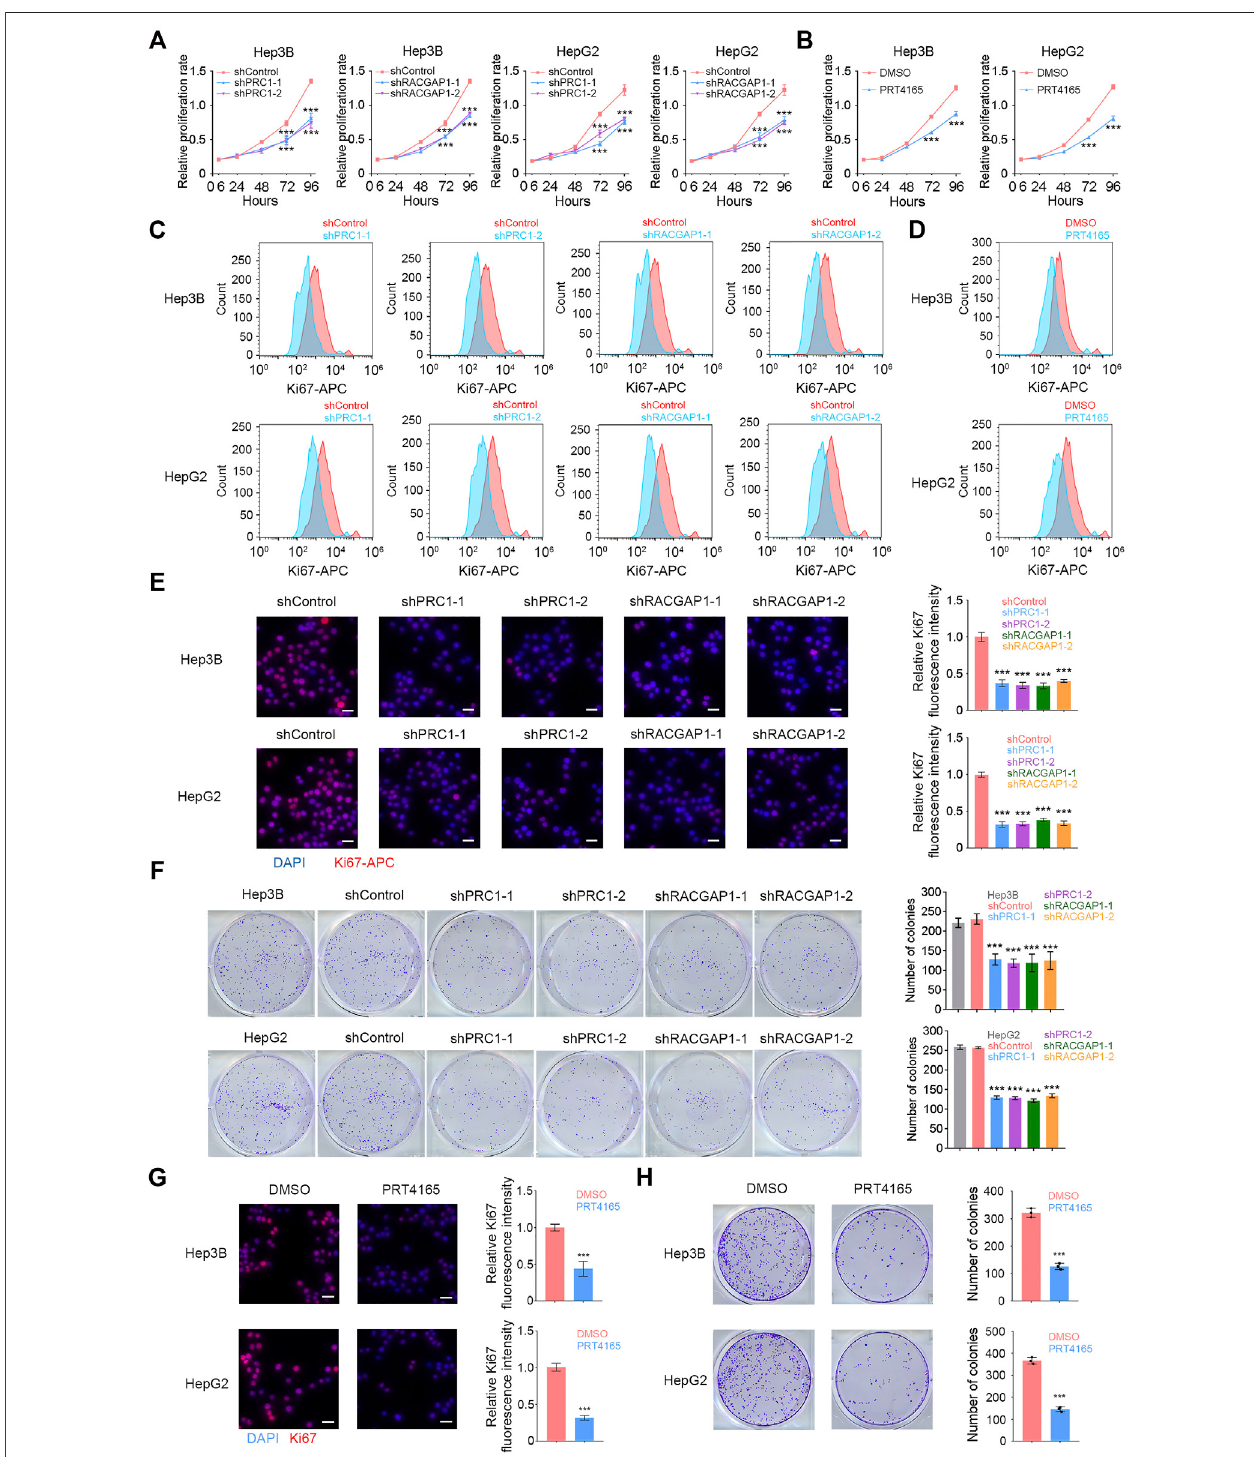
FIGURE 3 | PRC1 and RACGAP1 drive the propagation of liver cancer. (A,B) (A) Two thousand Hep3B or HepG2 cells with PRC1 or RACGAP1 knockdown and (B) two thousand Hep3B or HepG2 cells treated with 10 μ M PRT4165 or DMSO were seeded in 96-well plates and detected by CCK-8 at 6, 24, 48, 72, and 96 h, respectively.ThecellproliferationratewasdenotedbyOD450. (C,D) (C)1×10 4 PRC1orRAPGAP1depletedHep3B(upperpanels)andHepG2(lowerpanels)cells; (D) 1×10 4 Hep3B(upperpanels)andHepG2(lowerpanels)cellsadded10 μ MPRT4165orDMSOwereusedforintracellularstainingforKi-67. (E,G) (E)1×10 5 PRC1 orRAPGAP1 depletedHep3B(upperpanels)andHepG2(lowerpanels) cells; (G) 1×10 5 Hep3B(upperpanels) andHepG2(lowerpanels)cellsadded10 μ MPRT4165